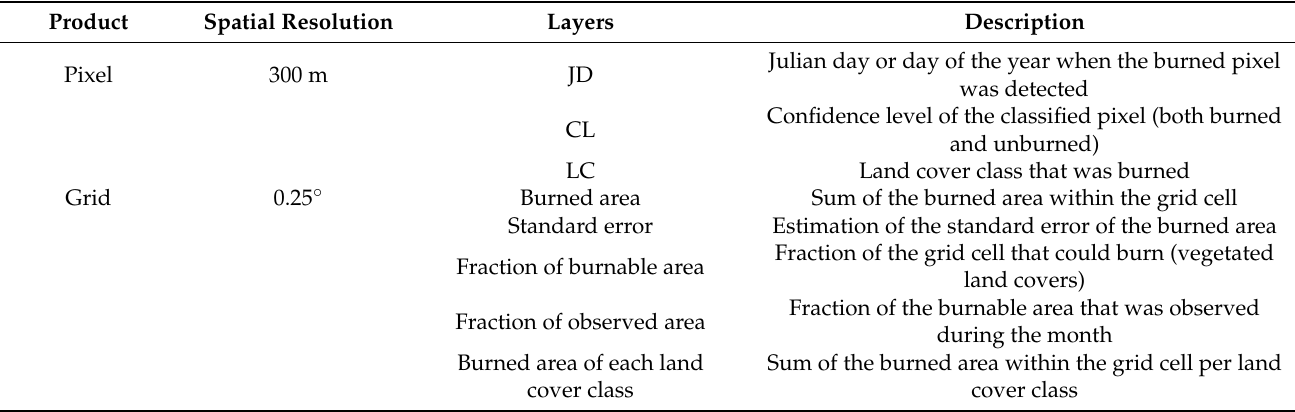
Figure 3. Continental tiles of the global BA pixel product. Table 2. Pixel and grid products’ specifications.